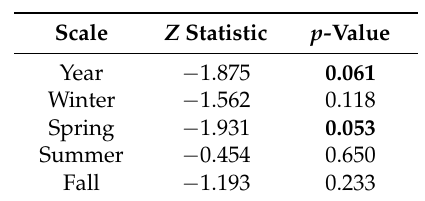
Table 5. Analysis of the long-term trend of annual and seasonal maximum daily flows using the Mann-Kendall method.